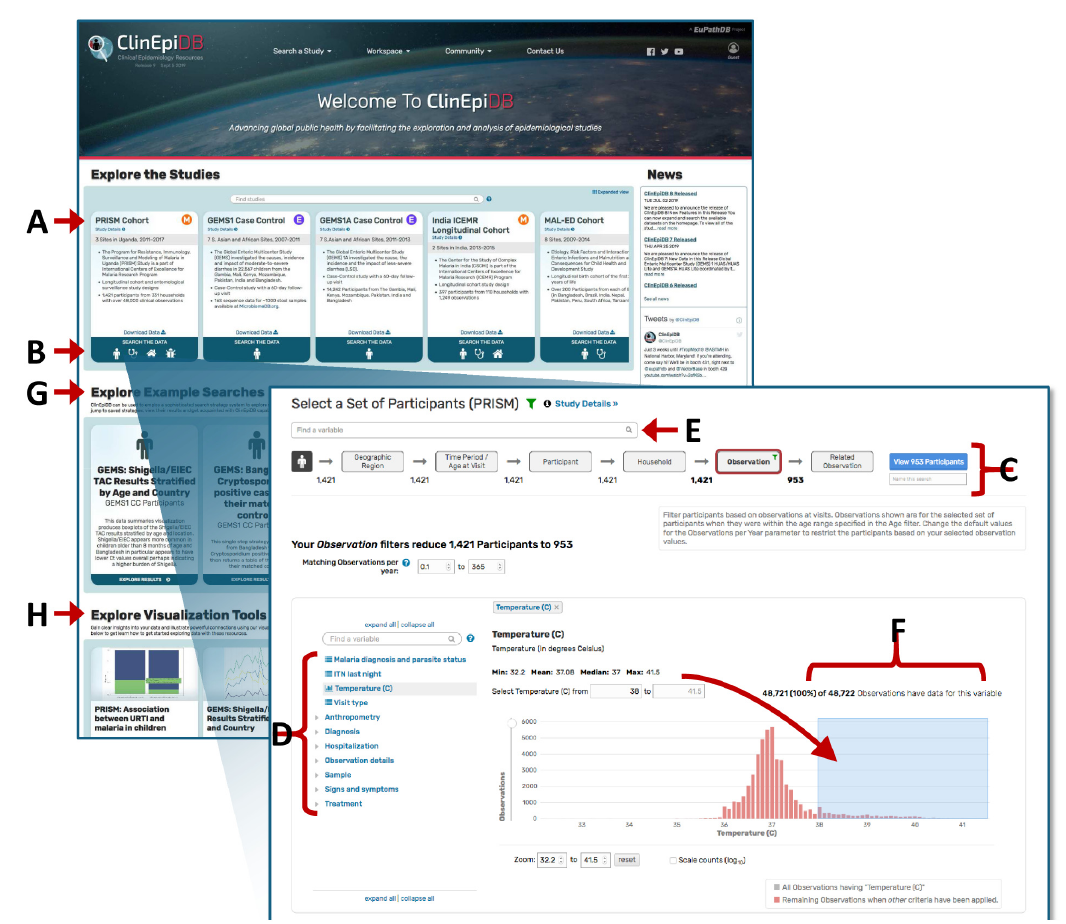
Figure 2. Using the Search Wizard to explore variables. (A) Clicking a card study name opens a study page. (B) Clicking on a card search icon initiates a search. (C) The Search Wizard categorizes the variables into discrete steps. The grey buttons let users move between steps. (D) The variable tree contains all variables within that step of the Search Wizard. To subset the data, users can open a variable from this tree. (E) The “Find a variable” search bar searches for variables based on variable names and values across all Search Wizard steps. (F) Continuous data are displayed as a histogram and can be constrained by typing the exact range of values or clicking and dragging the mouse across the range of interest. (G) Clicking cards underneath “Explore Example Searches” opens up examples of searches conducted using the datasets indicated. These searches can be edited. (H) Clicking cards underneath “Explore Visualization Tools” opens up examples of how the exploration applications can be used.